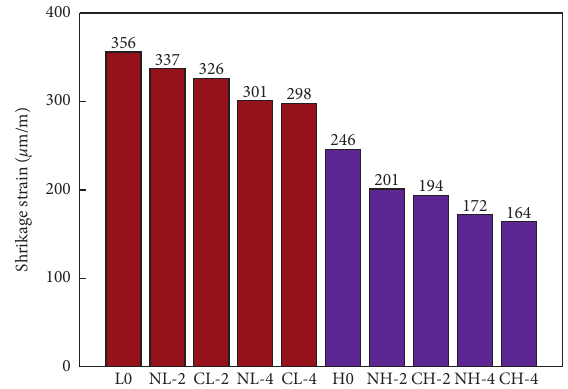
Figure 18: Shrinkage rate of concrete at the age of 28d.